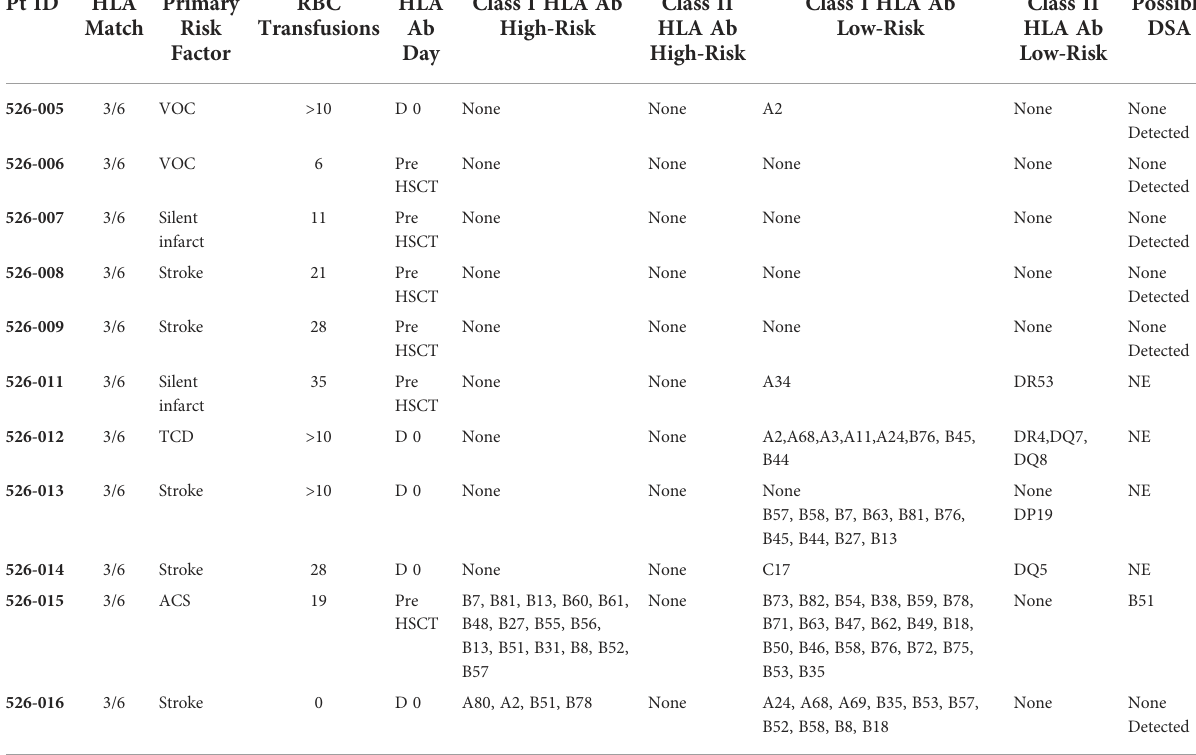
TABLE 2 RBC transfusions history and HLA antibodies prior to HISCT (11 patients tested for HLA antibodies/19 total subjects). Pt